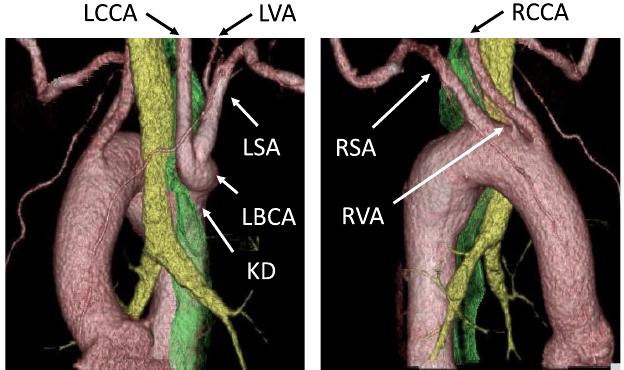
Figure 2 Three-dimensional computed tomography showing the right- side aortic arch branches from proximal to distal in the following order: right common carotid artery (RCCA), aberrant right vertebral artery (RVA), right subclavian artery (RSA), and the aneurysmal Kommerell diverticulum (KD). The KD connects to the left common carotid artery (LCCA), branching into the common carotid artery (LCCA) and the left subclavian artery (LSA). The esophagus (dark green) is compressed by the trachea (light green), and the KD connects to the LCCA.